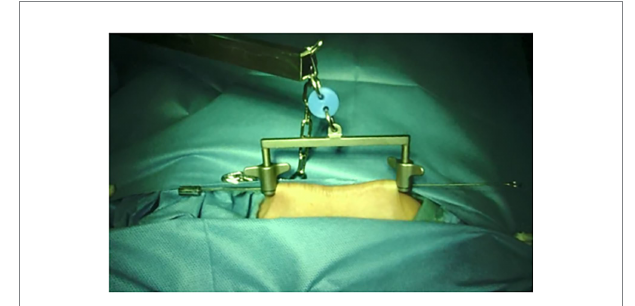
FIGURE 1 Presented the abdominal wall suspension skill with one steel.